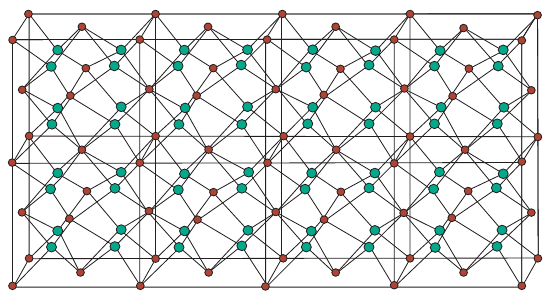
Figure 4: Crystal structure of TiF